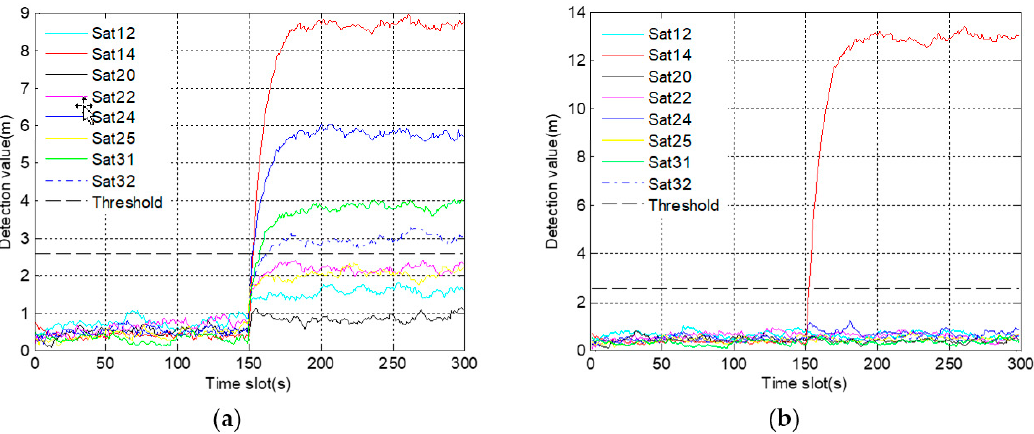
Figure 12. The graph of fault identification statistics corresponding to abrupt fault: ( a ) before using a robust algorithm, ( b ) after using a robust